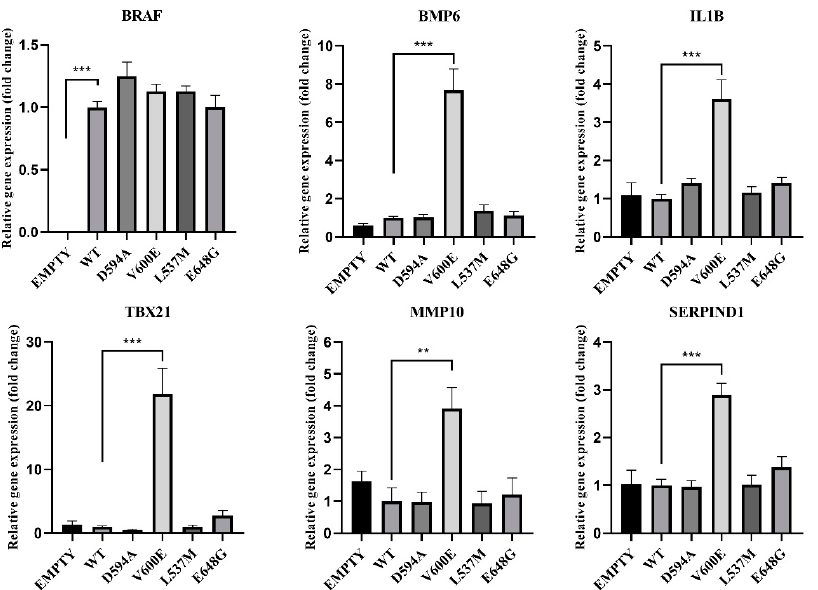
Figure 11. Effects of BRAF mutations on the selected gene expression. A significant upregulation (fold change) of BMP6 , IL1B , TBX21 , MMP10 , and SERPIND1 was seen in BRAF V600E-transfected THLE-2 cells. Results are presented as a fold change in contrast to the expression of BRAF WT-transfected cells (±SEM). B2M was subjected as a reference gene. The statistical analysis was performed using a one-way ANOVA with Bonferroni correction, n = 3, ** p < 0.01, *** p < 0.001.